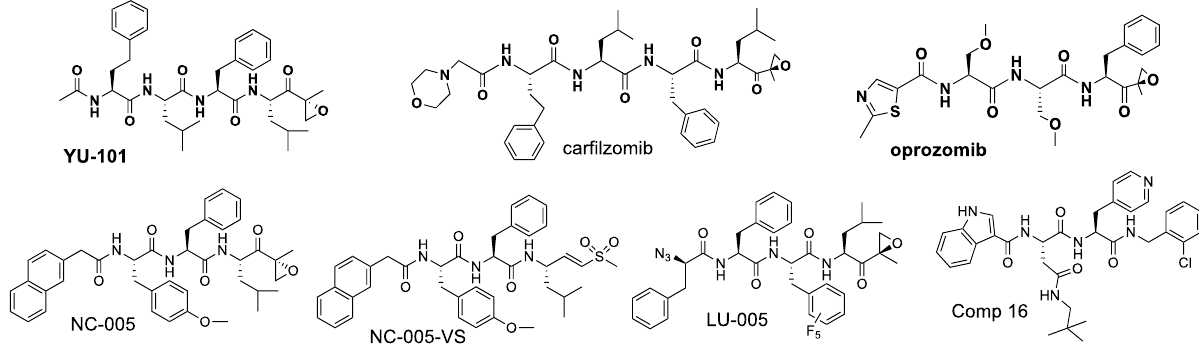
Figure 3. Inhibitors of β 5 sites. Commercially available compounds are bold.